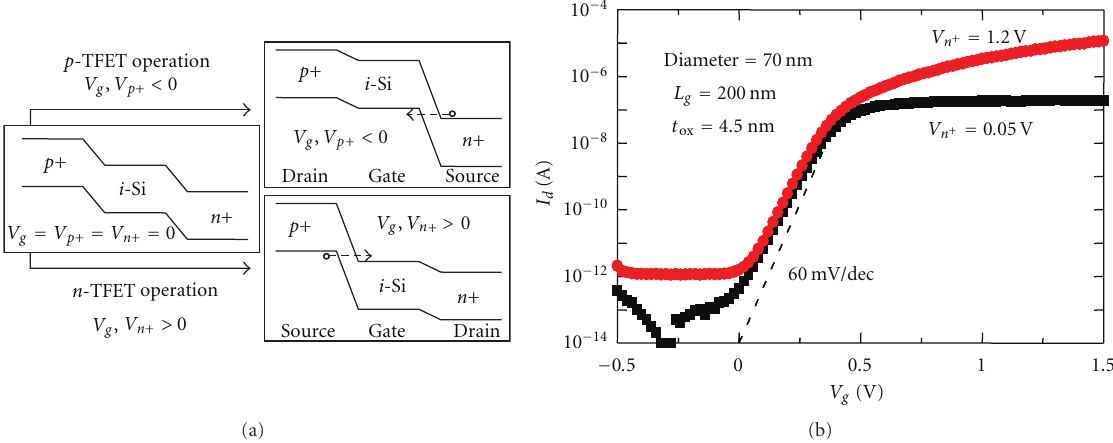
Figure 6: (a) Band diagram of TFET showing tunneling junction, (b) I d - V g and characteristics of a vertical SiNW TFET with diameter 70nm, gate length 200 nm and gate oxide thickness 4.5nm. (Reprinted with permission from [28]. [2009]